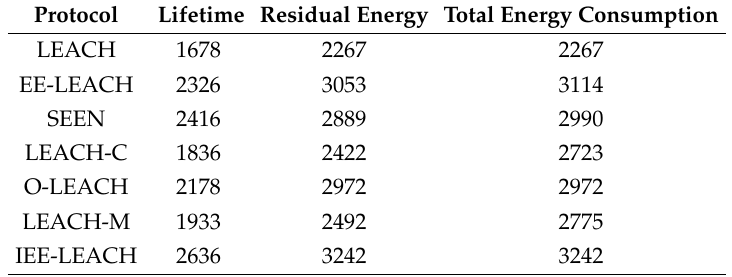
Figure 14. Comparison of total energy consumption of the network for a large sensor field. Table 3. A performance comparison between different protocols in a 100 m × 100 m sensor field.